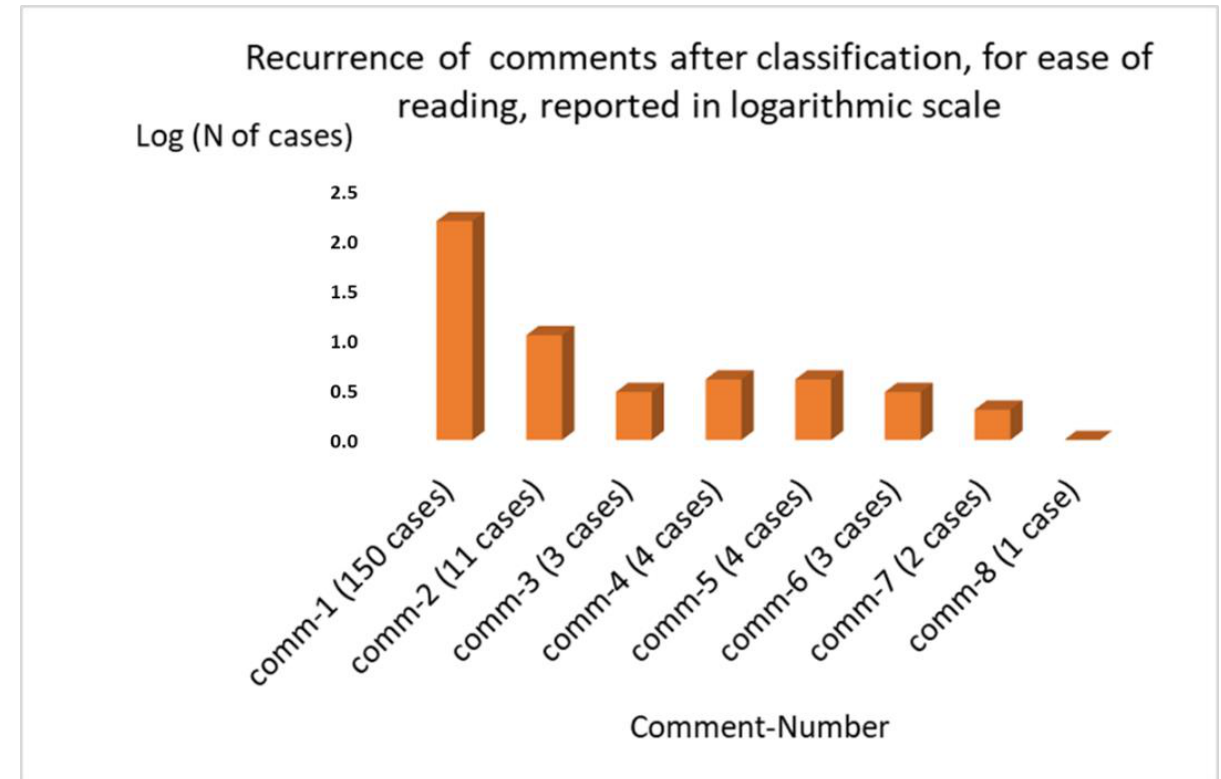
Figure 6 highlights in a logarithmic scale the outcome for each group of comments.